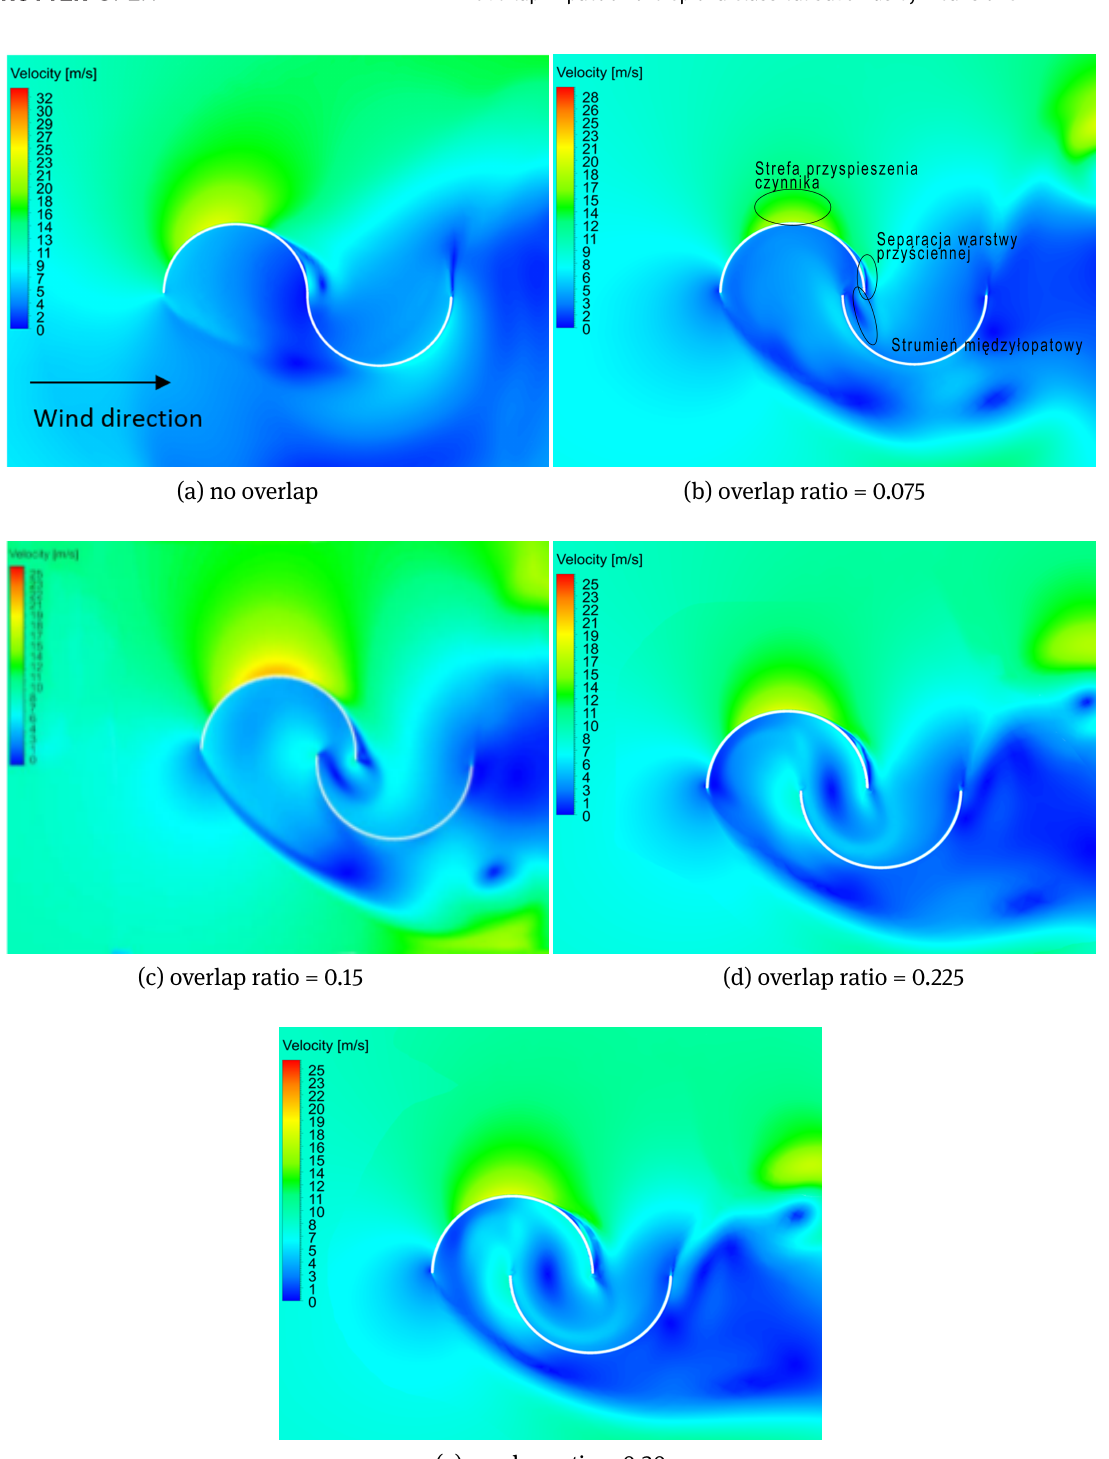
Figure 8: Velocity distribution in stn. frame for different Savonius wind turbines at